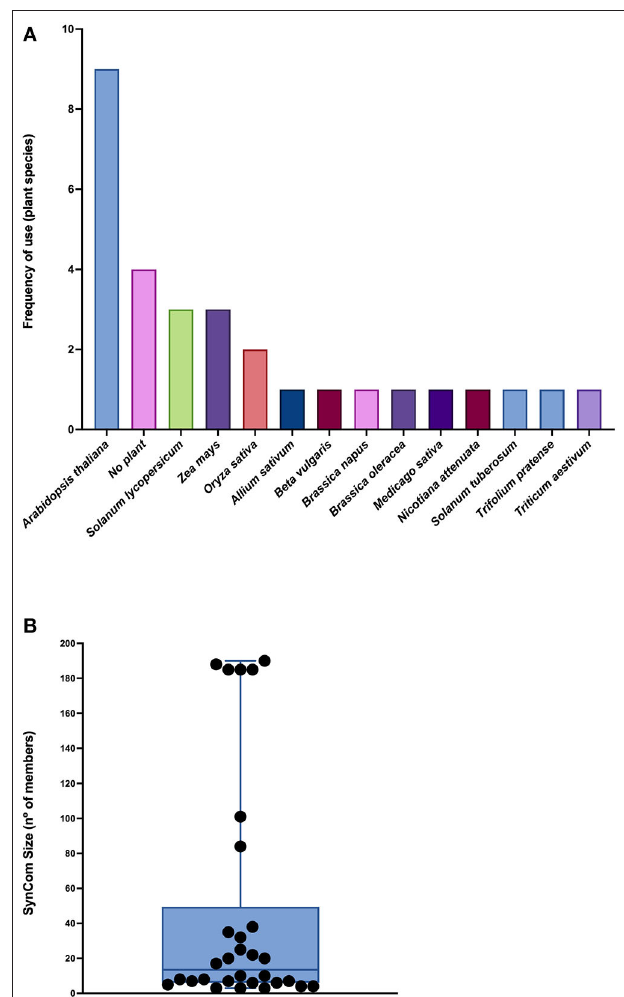
FIGURE 1 | Plant models and SynCom sizes reported in the literature. (A) Frequency of use of plant species in the selected articles. (B) Box plot showing the number of members used in SynComs. Each dot represents an article. The horizontal line corresponds to the